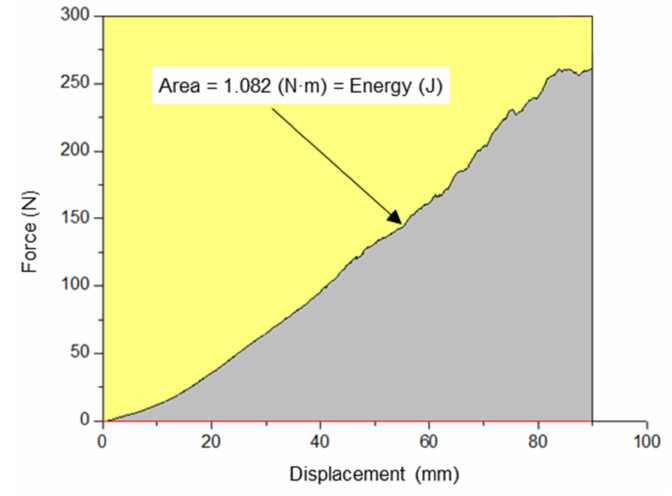
Figure 3. Energy measurement method.